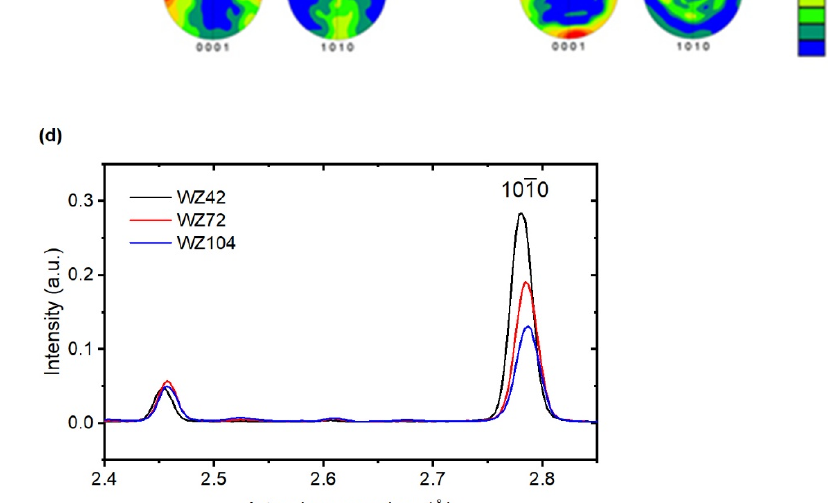
Figure 1. Initial microstructures and texture of the ( a ) WZ42, ( b ) WZ72, ( c ) WZ104 alloys, the intensity of the {1010} peak evaluated from ND data ( d ).